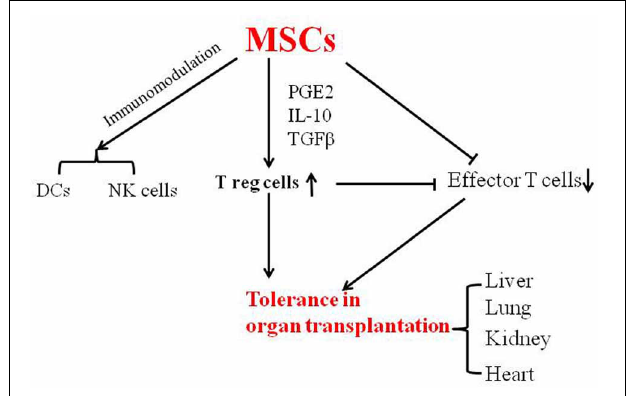
FIGURE 1 | MSCs induce tolerance in organ